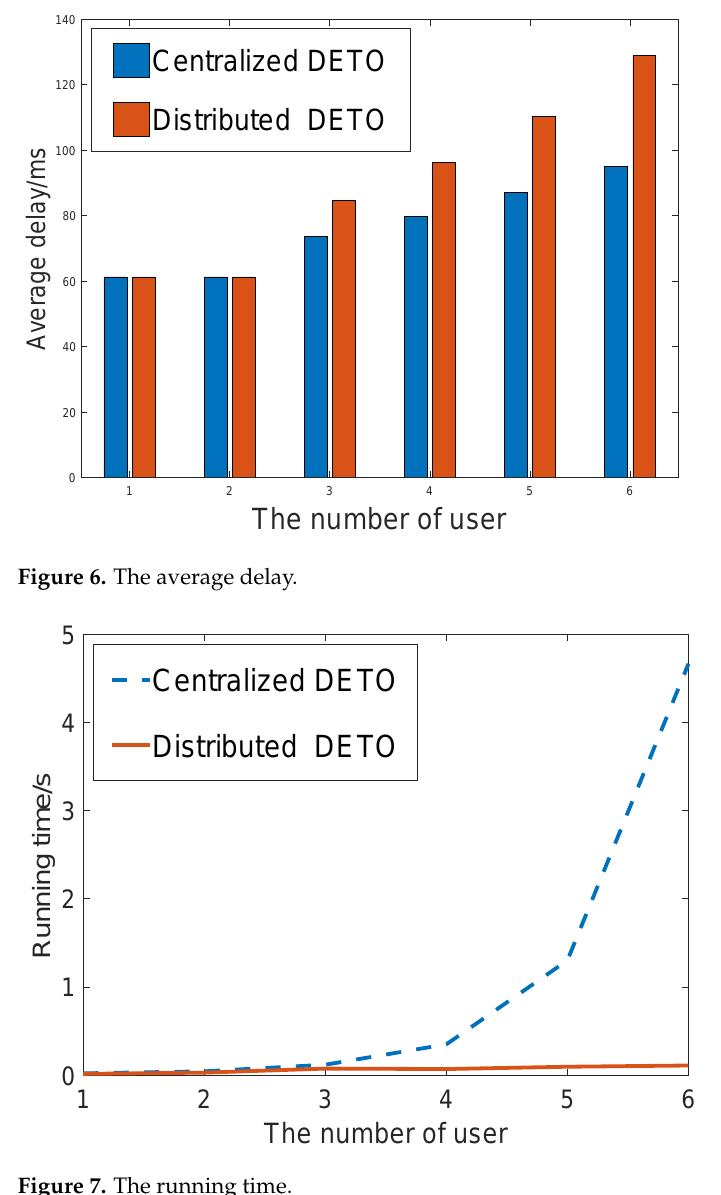
Figure 7. The running